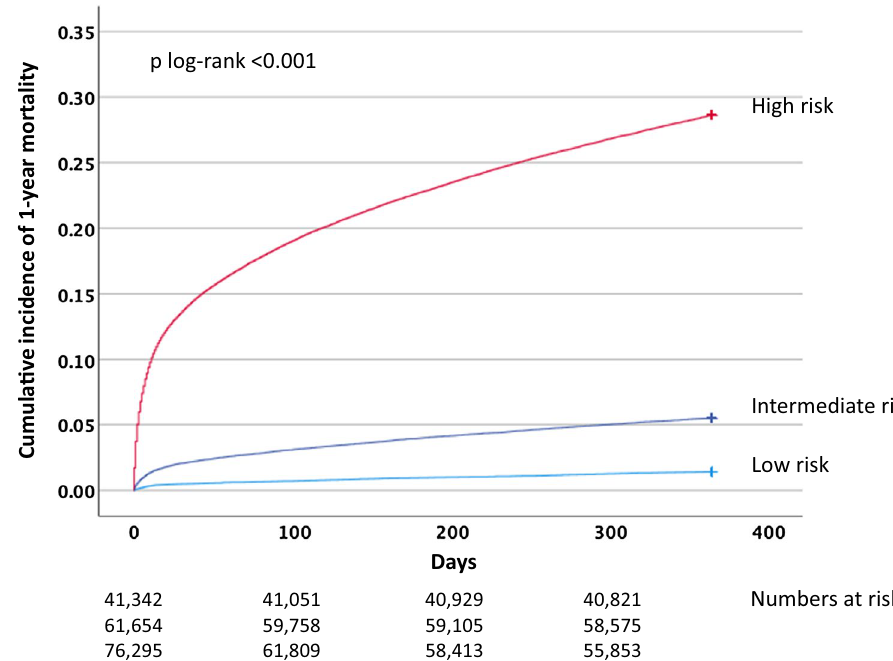
Figure 2. Cumulative incidence of 1-year all-cause mortality across patient cohorts with low, intermediate and high risk.